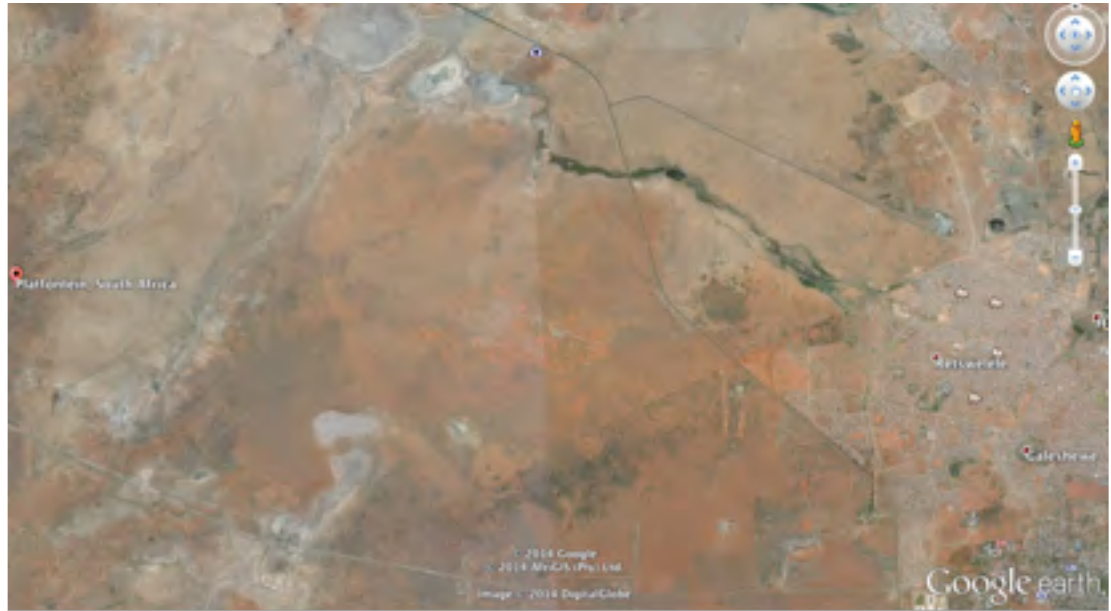
Map 5 Satellite image showing the dark line of raw sewage emanating from the Gogga Pump station – the largest wastewater treatment works in the Kimberley area. The highly dangerous spill is on the communal property of the San at Platfontein (Google